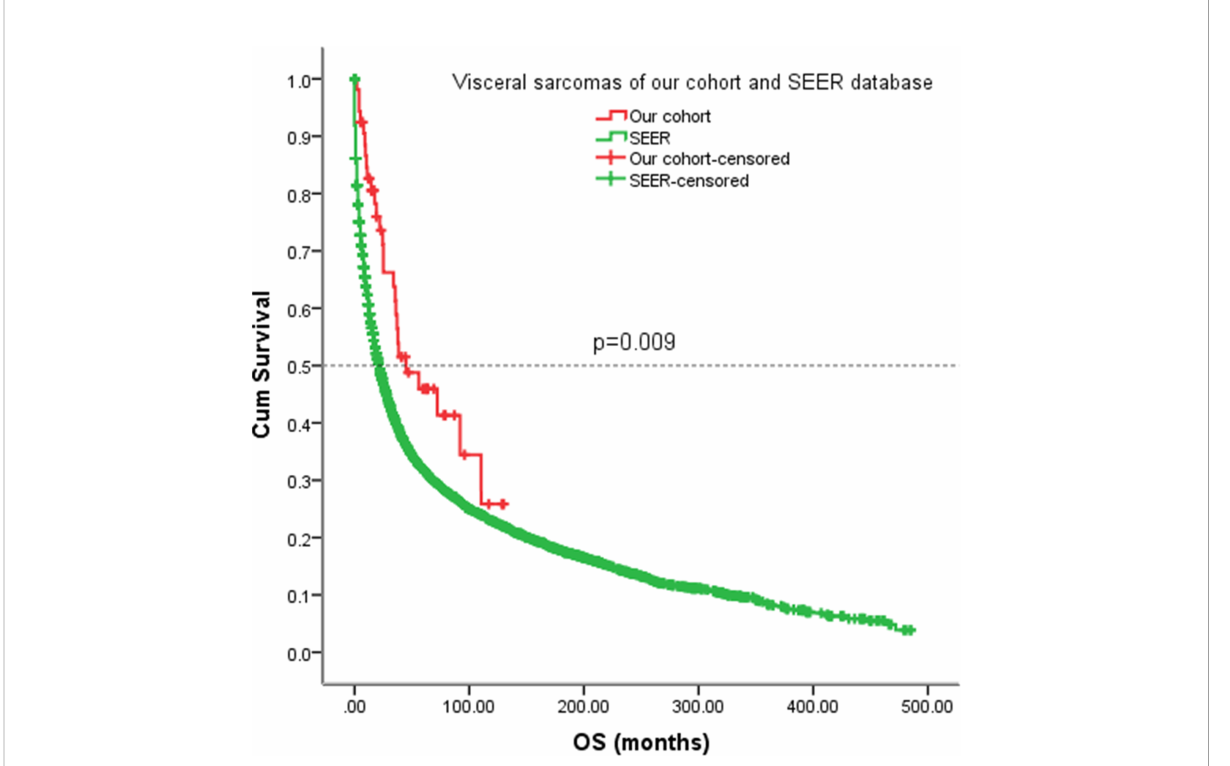
FIGURE 8 Kaplan-Meier analysis of OS for patients with visceral sarcomas of our cohort and SEER database.